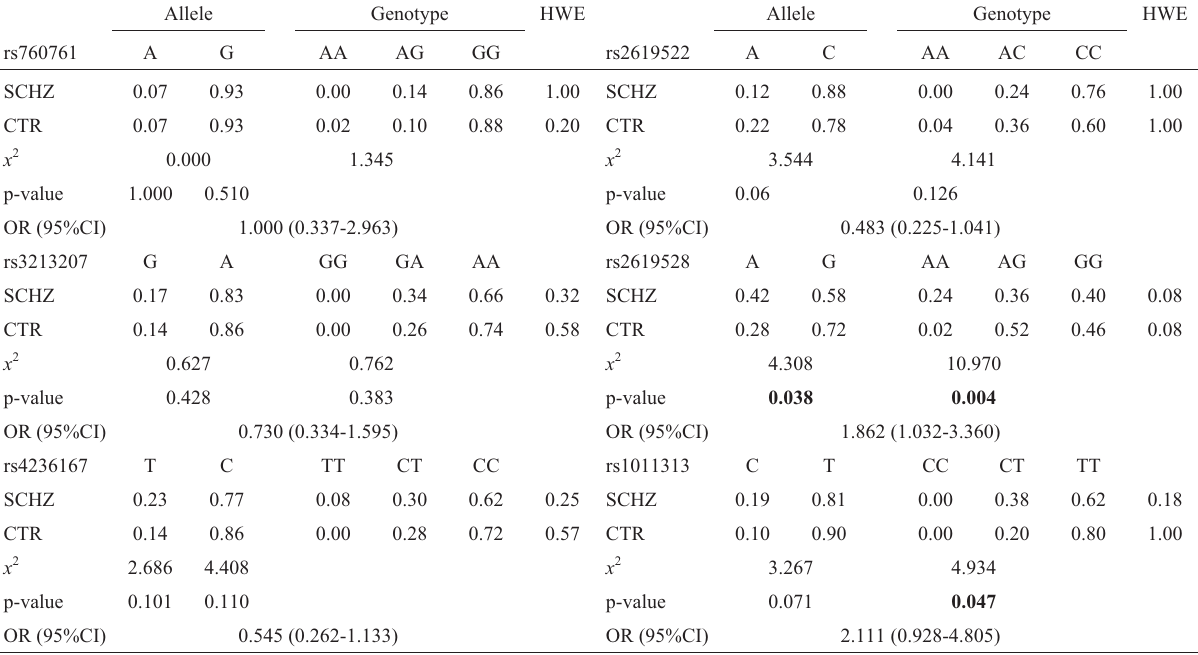
Table 3 - Allele and genotype frequencies for the 6 SNPs of the DTNBP1 gene in stage 1 consisting of 50 patients and 50 controls. Allele Genotype HWE Allele Genotype